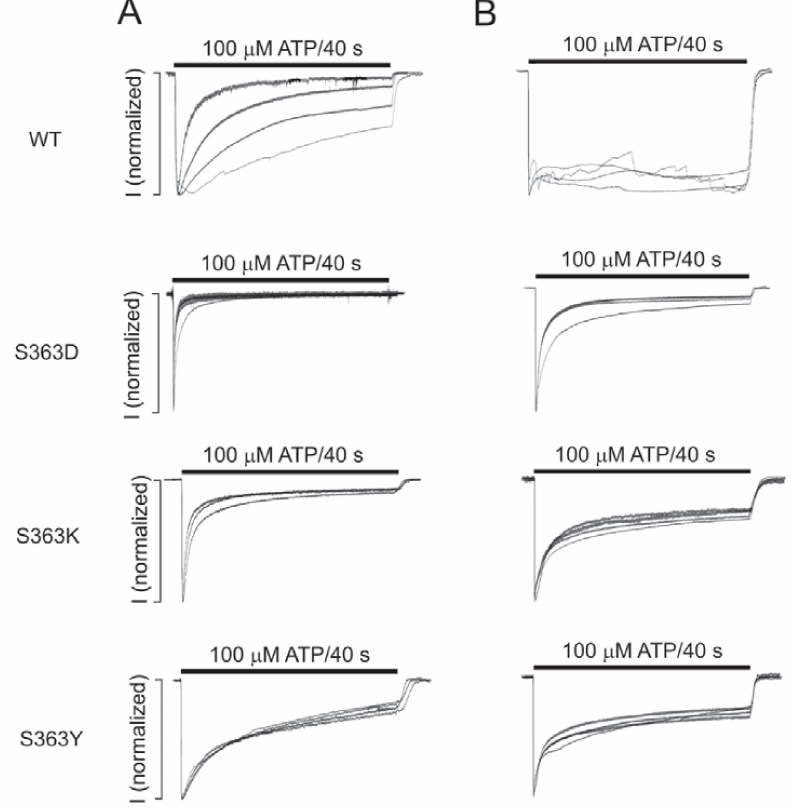
Figure 9. The patterns of extracellular ATP-induced current responses in cells expressing the wild type (WT) and the S363D, S363K, and S363Y mutant receptors of P2X2aR, in the absence ( A ) or in the presence of 5 mM intracellular ATP ( B ). The experiments were performed in HEK393 cells expressing P2X2R at a holding potential of − 60 mV. Notice the loss of UDD in all S363-P2X2aR mutants in the absence and presence of intracellular